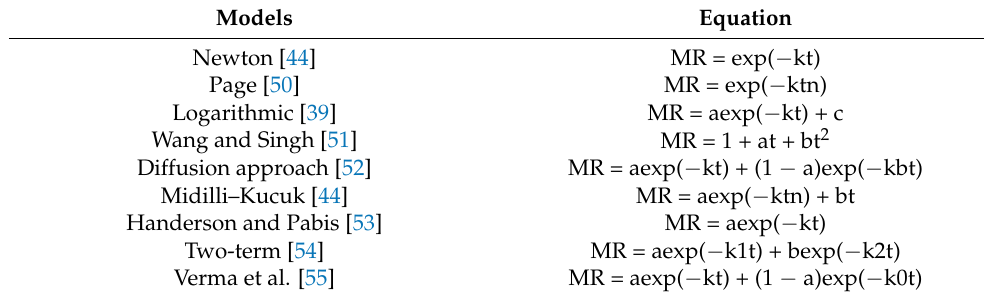
Table 1. Mathematical models